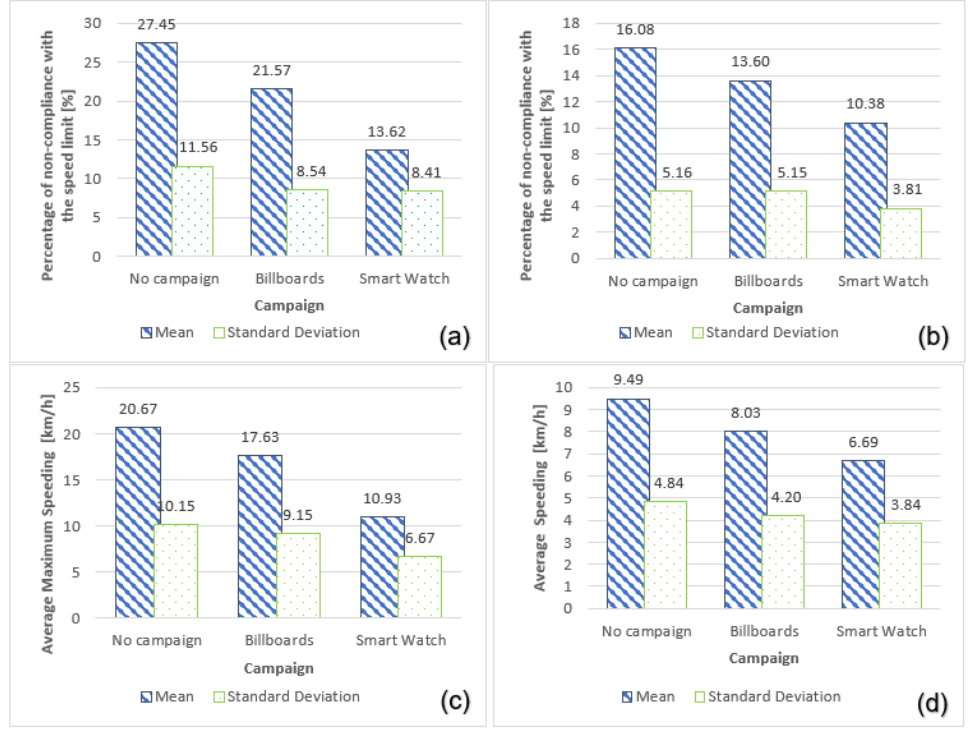
Figure 5. Results of three driving scenarios: no campaign, billboards, smart watch, for: ( a ) PncSL; ( b ) PST; ( c ) AMS; and ( d ) AS.